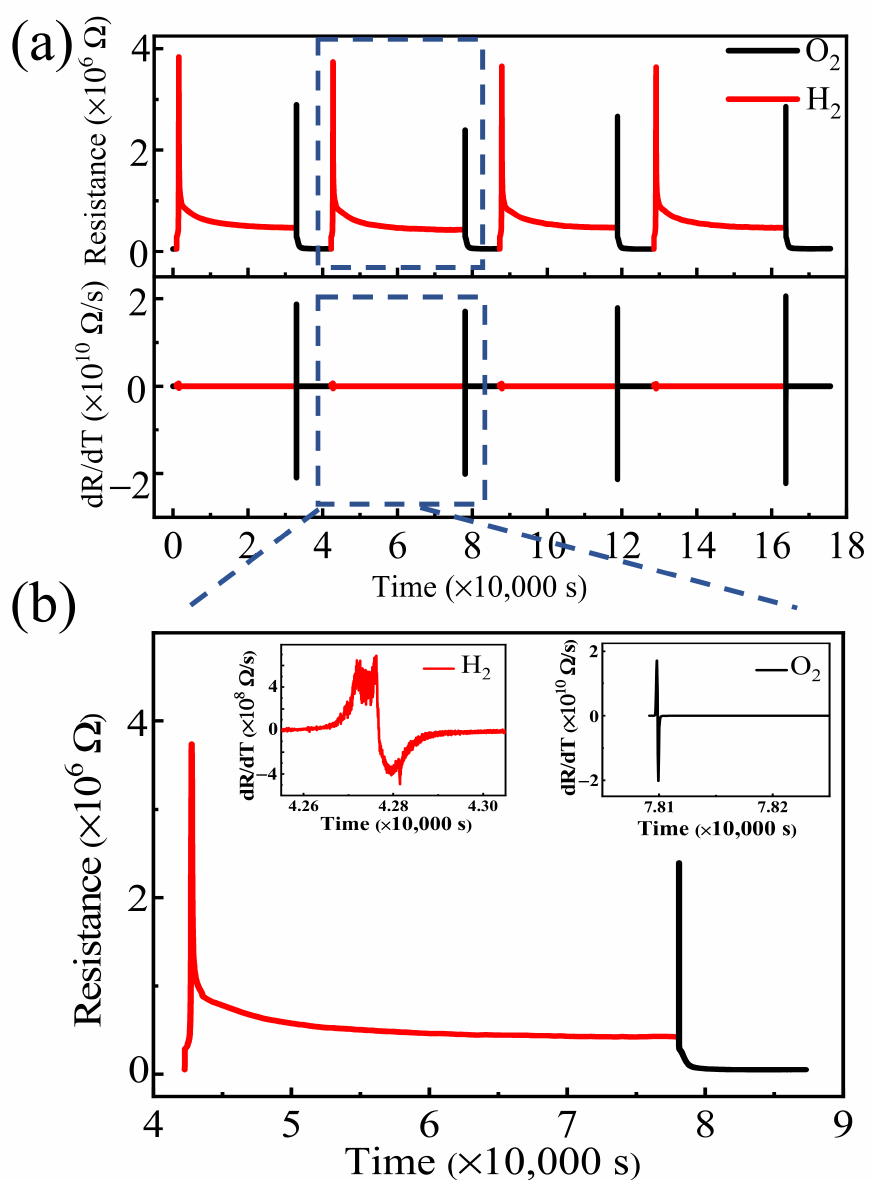
Figure 3. ( a ) R(t) vs. t and the corresponding dR(t)/dt vs. t curves of PBCC thin films under oxidizing/reducing atmospheres at 450 ◦ C; ( b ) A zoomed-in view of the R(t) vs. t curve for one oxidation/reduction cycle, and the insets are the corresponding dR(t)/dt vs. t curves of PBCC thin film under O 2 /H 2